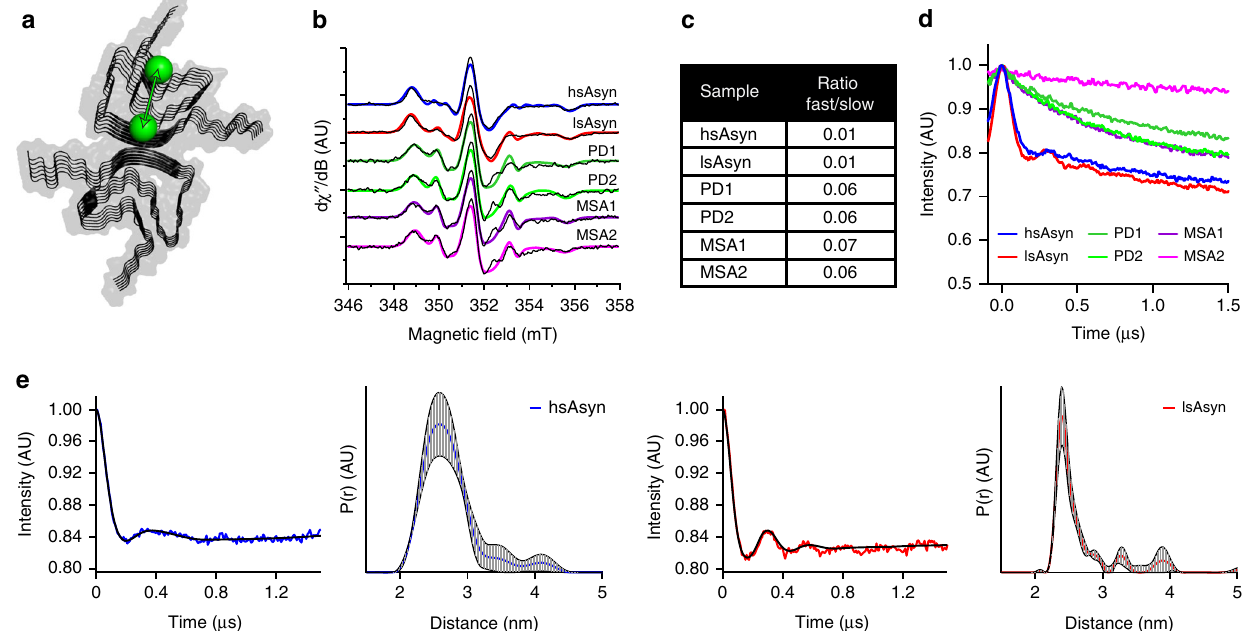
Fig. 7 EPR spectroscopy of aSyn fi brils. a Schematic representation of the location of MTSL spin labels (green balls) attached to residues 54 and 90. b Continuous wave EPR spectra of aSyn fi brils. Fits derived from a two-spin simulation are shown as colored lines. c Dynamic parameters (weight: fast/ slow) of MTSL spins derived from fi tting continuous wave EPR spectra. For both spin species, g ≈ [2.008, 2.006, 2.002] and A/ h ≈ [17.8 – 19 18.5 – 19 93 – 110] MHz. The peak-to-peak isotropic linewidths (lwpp) for the two species were lwpp (slow) = 0.52 – 0.67 mT and lwpp (fast) = 0.3 – 0.4 mT, respectively. d Dipolar modulation (without background correction) of aSyn fi brils from 34 GHz four-pulse PELDOR experiments. e Dipolar modulation (corrected for background) and normalized distance distribution determined by 34 GHz four-pulse PELDOR experiments for hsAsyn (blue) and lsAsyn